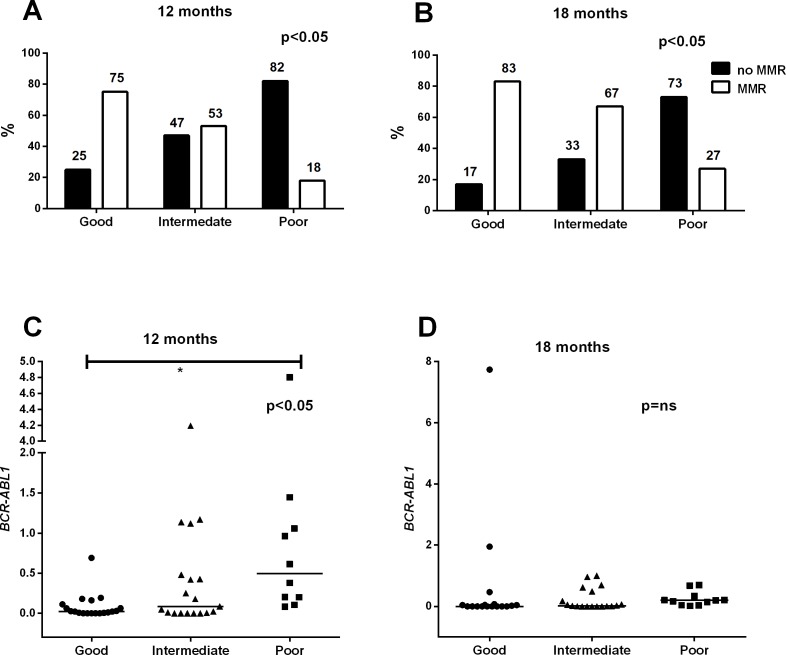
Poor responders have significantly worse long-term outcomes.The patients were divided into three groups based on the 1-month FC (poor responders FC>1, intermediate 0.31<FC<1, good FC<0.3; Fig 1A). A–B) The comparison of the three groups showed differences in the MMR rates at 12 (p<0.05) and 18 months (p<0.05). C–D) The BCR-ABL1 transcript value at 12 and 18 months in the three response groups. In A and B, statistical significance was analyzed with a chi-square test. In C and D, an unpaired two-tailed t-test was applied, and median values are noted with lines.